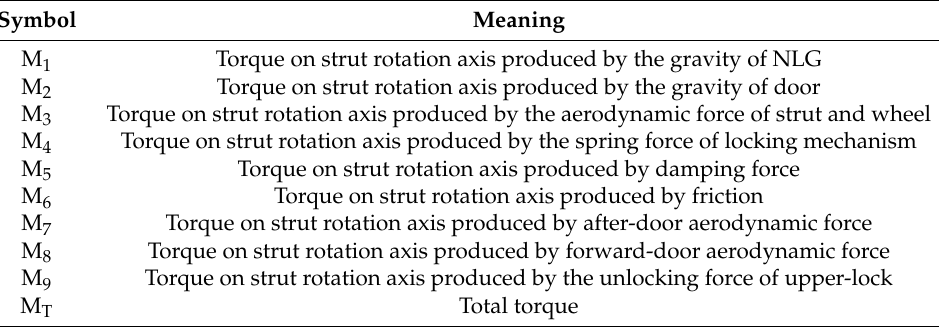
Table 1. Explanations of